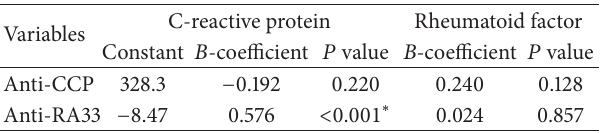
Table 6: Linear regression analysis of the diagnostic markers of RA with CRP and RF